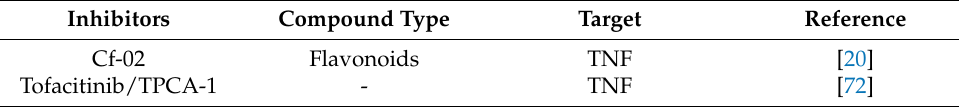
Table 4. Small molecule inhibitors targeting TNF for